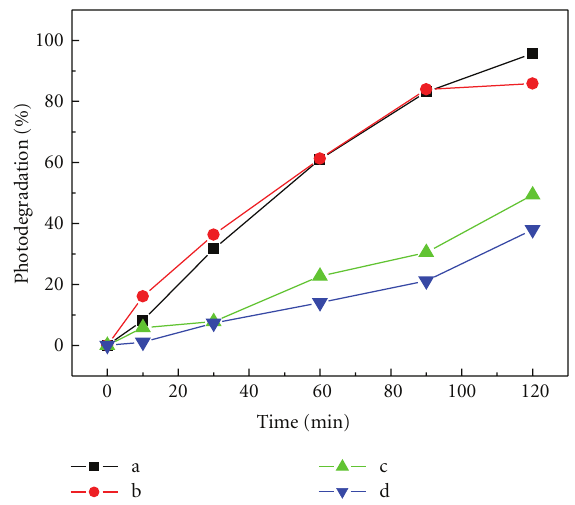
Figure 7: Photocatalytic performance of the as-prepared meso- porous TiO 2 and P25 under simulated sunlight irradiation: pho- todegradations of (a) the mesoporous TiO 2 on RhB, (b) P25 on RhB, (c) the mesoporous TiO 2 on phenol, and (d) P25 on phenol.